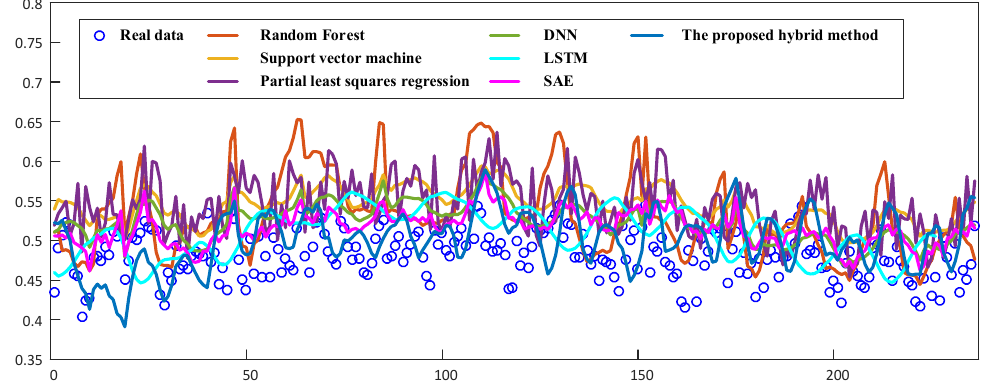
Figure 7. Soft sensing results of comparative models on testing dataset.